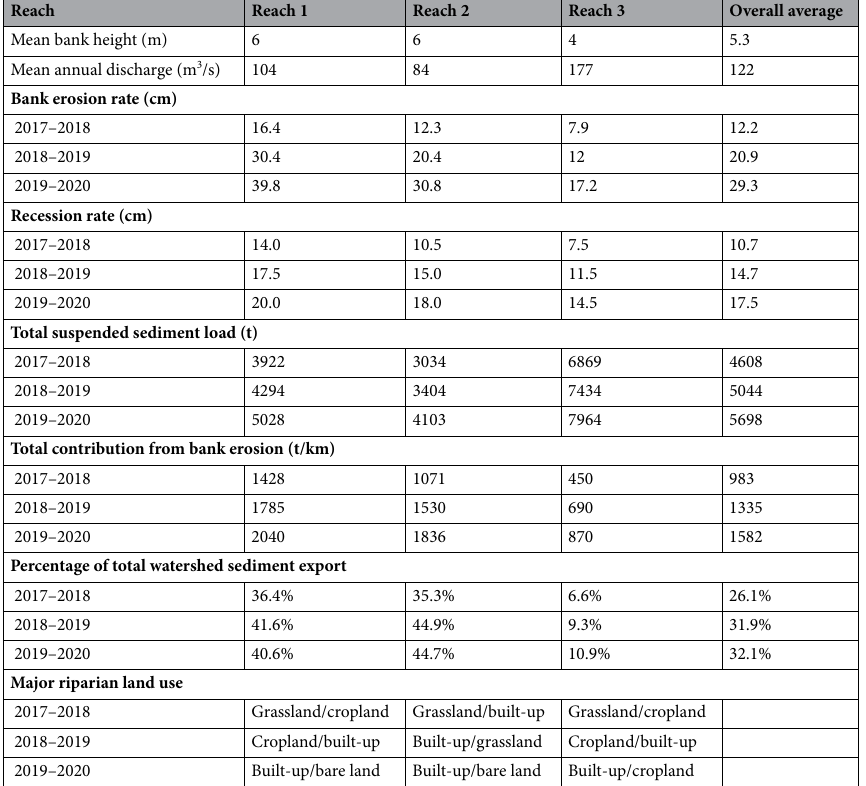
Table 5. Summary of average value per reach of bank height, mean annual discharge, erosion and recession rates, total suspended sediment load, and sediment export from the Nkisi River